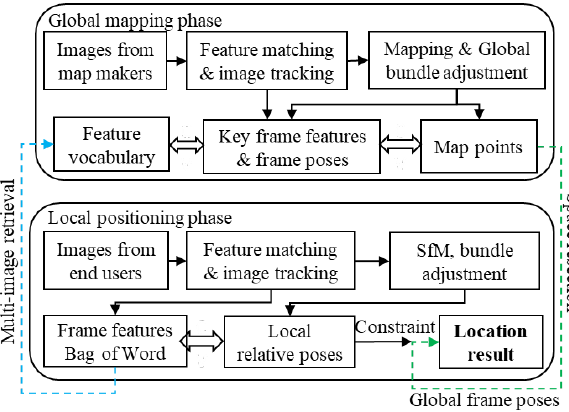
Figure 1. Workflow of our indoor localization